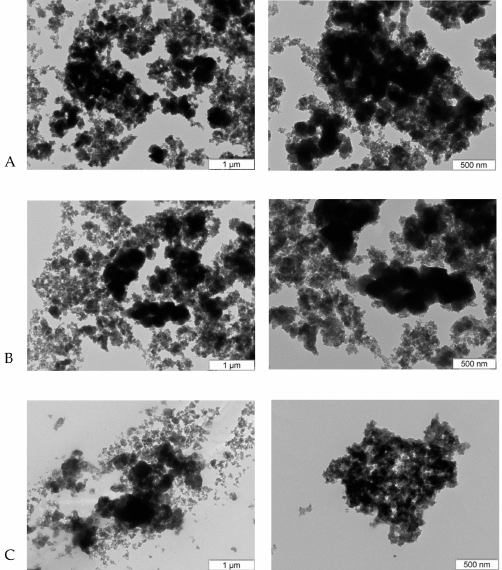
Figure 3. Transmission electron microscopy (TEM) images of a-TiO 2 -based nanoparticles (NPs), namely: ( A ) a-TiO 2 NPs, ( B ) a-TiO 2 -NH 2 NPs, and ( C ) a-TiO 2 / CS NPs. (for each composition two di ff erent amplifications are shown—1 µ m and 500